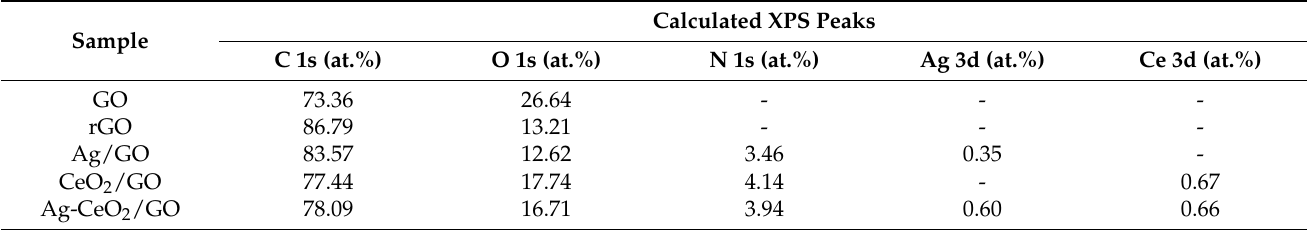
Table 3. Elemental composition of the samples according to survey XPS